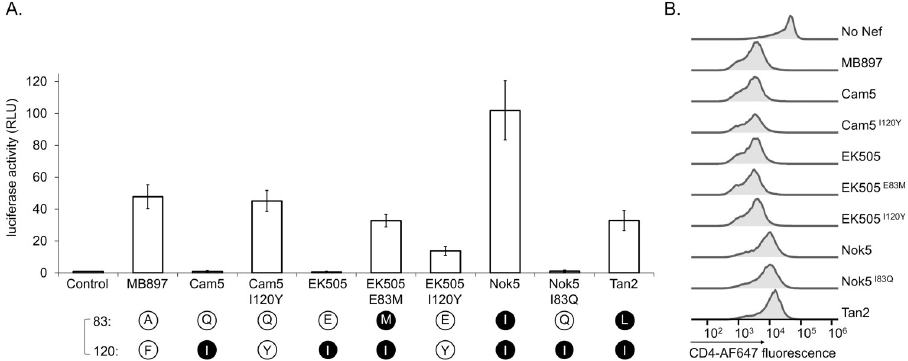
Fig 5. R-clamp architecture of SIVcpz Nef proteins. (A) HZ-1 cells were transfected with an AP-1-luciferase reporter alone (Control) or together with wild-type or the indicated mutants of Nef from SIV strains from Pan troglodytes troglodytes (MB897, Cam5, and EK505) or Pan troglodytes schweinfurthii (Nok5 and Tan2). Luciferase activity in the transfected lysates was analyzed as in Fig 1C. The data shown are derived from three independent experiments, with SE indicated by error bars. The amino acid combinations at positions 83 and 120 are indicated as single-letter symbols and color-coded as explained in Fig 4. (B) CD4 downregulation by Nef in stably transduced Jurkat T cells was examined as in Fig 1C. Original dot plots are shown in S3